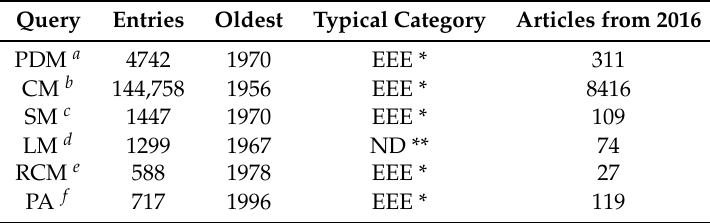
Table 1. Overview of the gathered data set.